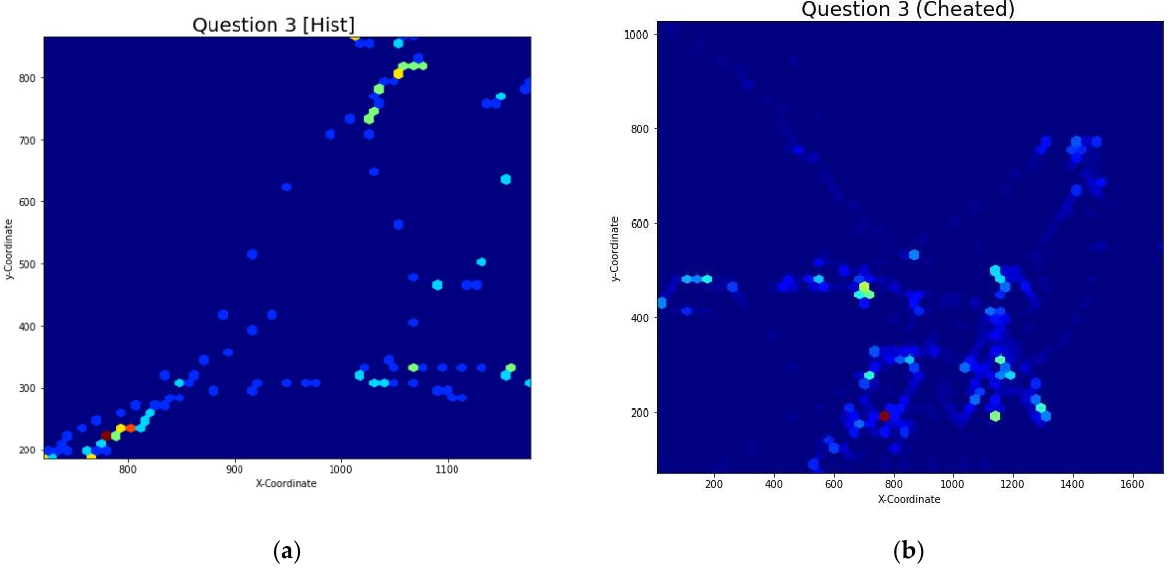
Figure 8. A histogram of raw mouse movements showing the difference in the frequency of move- ments is as follows: ( a ) a KDE plot of question 3 answered by students without cheating; ( b ) a KDE plot of question 3 answered by students who are allowed to cheat.